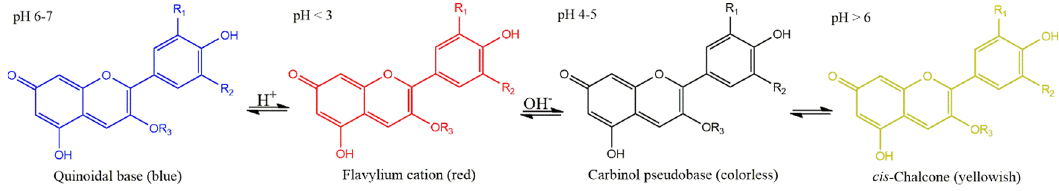
Figure 7. Anthocyanin molecular structures with respect of pH changes.